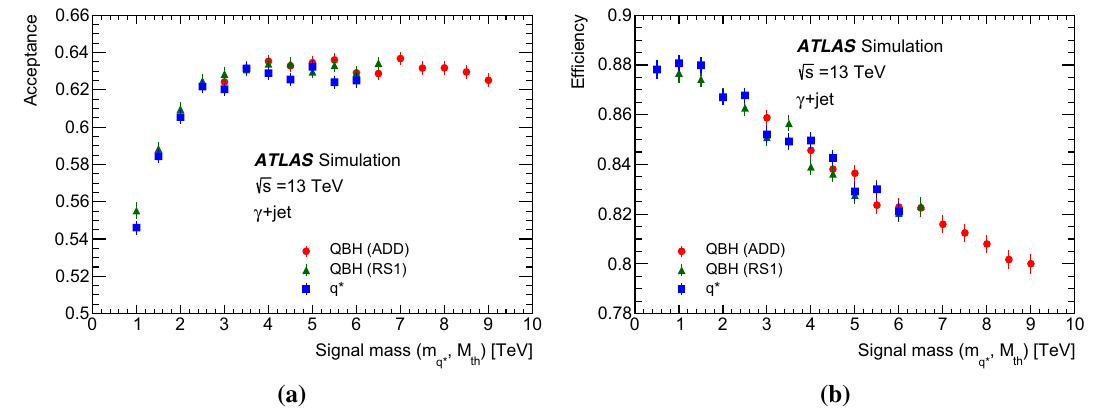
Fig. 1 a Fiducial acceptance and b selection efficiencies for the three signal models considered in the analysis as a function of the excited- quark mass m q ∗ or the QBH threshold mass M th . The fiducial region